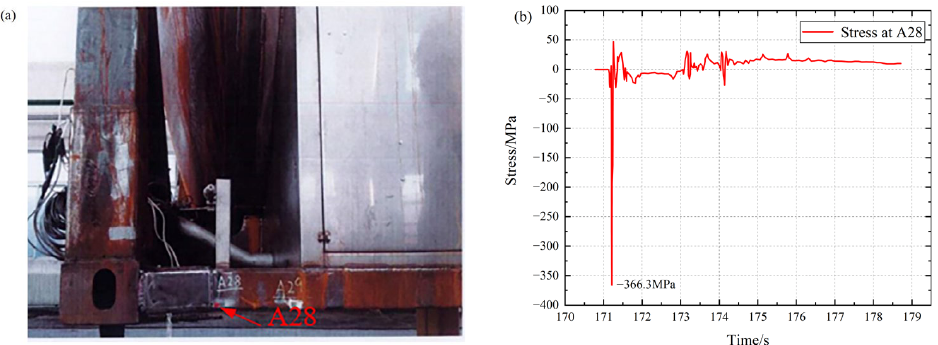
Figure 3. Measuring point A28: ( a ) location of A28; ( b ) the variation of stress at A28 over time.